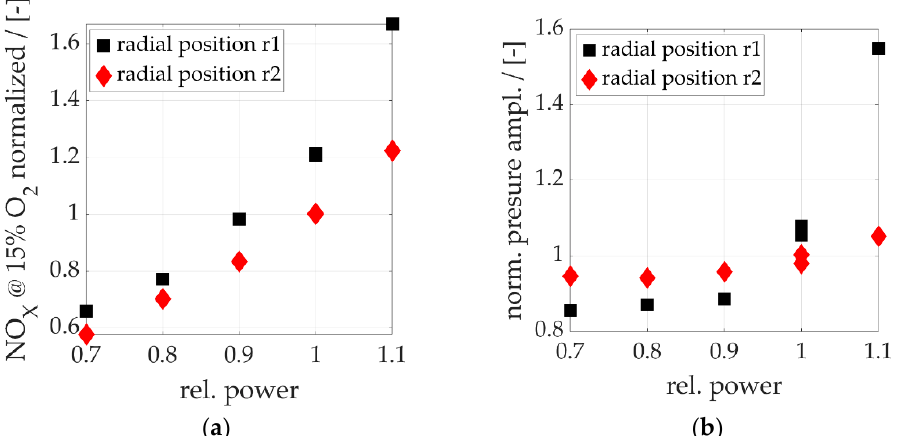
Figure 18. ( a ) Normalized NO X emissions and ( b ) normalized dynamic pressure amplitude with respect to the relative engine power obtained at the high-pressure test rig; two variants with different radial positions of the liquid-fuel main nozzles, with r1 < r2 .